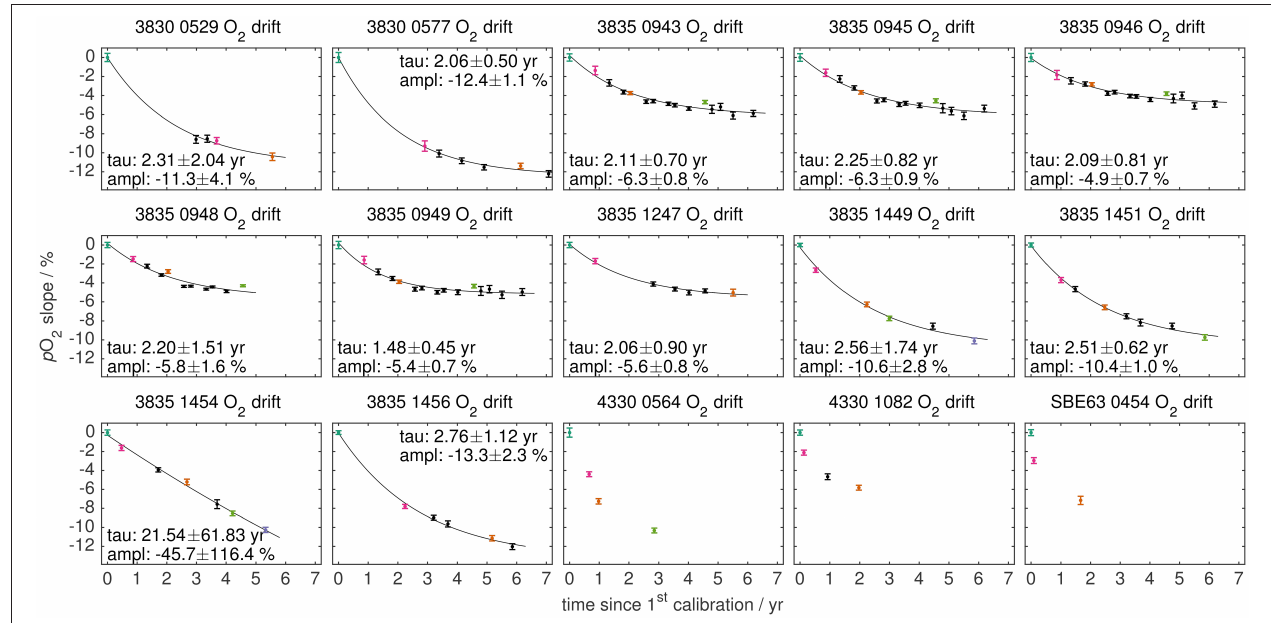
FIGURE 7 | Oxygen sensitivity change for all optodes: The p O 2 slope factor of a linear oxygen domain correction is shown against the time elapsed since the first calibration. Exponential fits are given for optodes with at least 5 calibrations, where tau represents the exponential time constant and ampl the amplitude (both with 95 % CI). The subset of colored calibrations is shown in Figures S4, S5 with the same color code.